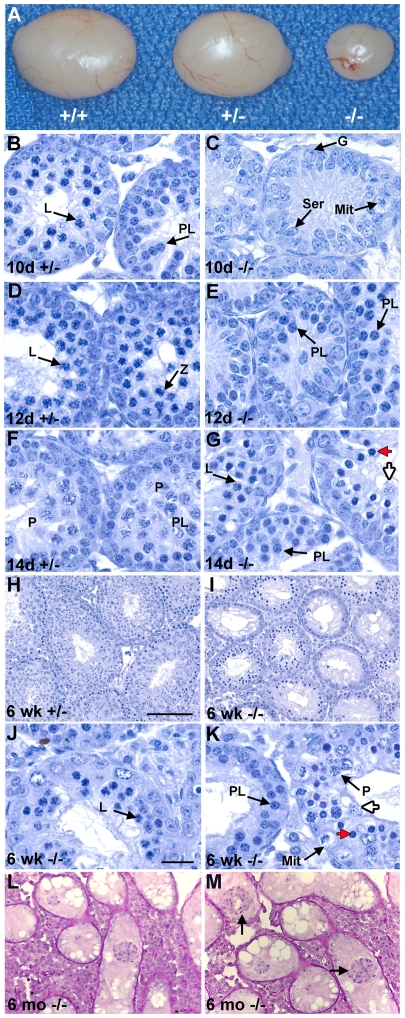
Gross and histological analysis of postnatal testes.(A) Gross analysis of testes from 7-week-old littermates. (B–M) Histological analysis of testes of Gasz
+/− and Gasz
−/− mice. (M) is a higher power magnification of (L) to show the lack of germ cells attached to the base of the tubule and sloughing germ cells in the lumen. G, spermatogonia; L, leptotene spermatocytes; M, meiotically dividing spermatocytes; Mit, mitotically dividing spermatogonia; P, pachytene spermatocytes, PL, preleptotene spermatocytes; Ser, Sertoli cells; Z, zygotene spermatocytes; dying spermatocytes with compact chromatin (red arrowhead); and with diffuse chromatin (open arrowhead); sloughing germ cells (black arrowheads). [Scale bars: 100 µm (B–C), 20 µm (D–K).]